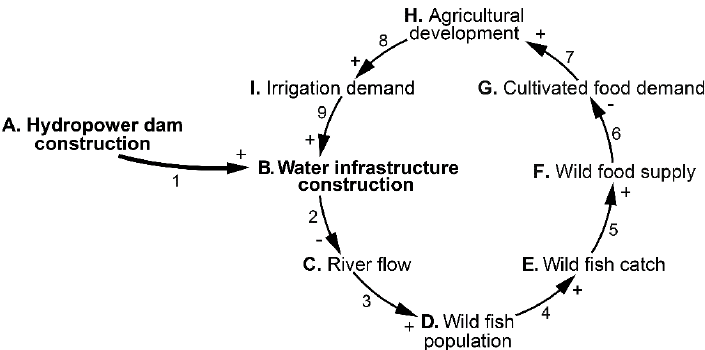
Figure 5. Food supply influence model in the lower Mekong Basin. Details of the variables A to I in Figure 5 and the causal links 1 to 9 are defined in Table 2 below.